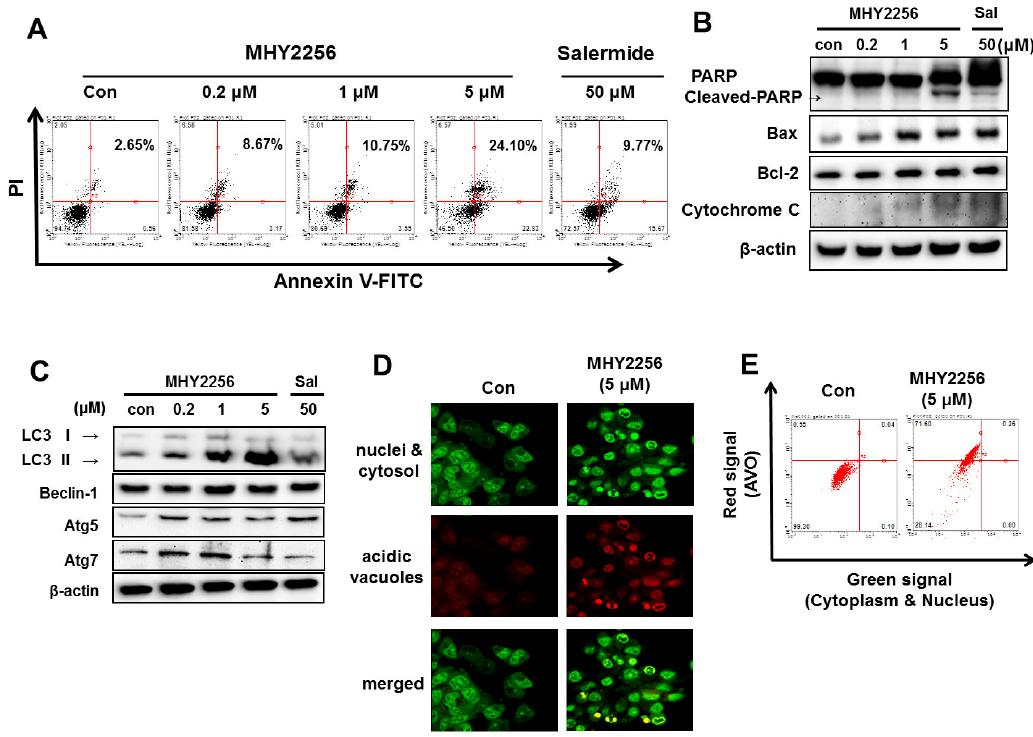
Figure 3. MHY2256 induced apoptosis and autophagy in Ishikawa endometric cancer cells. ( A ) The